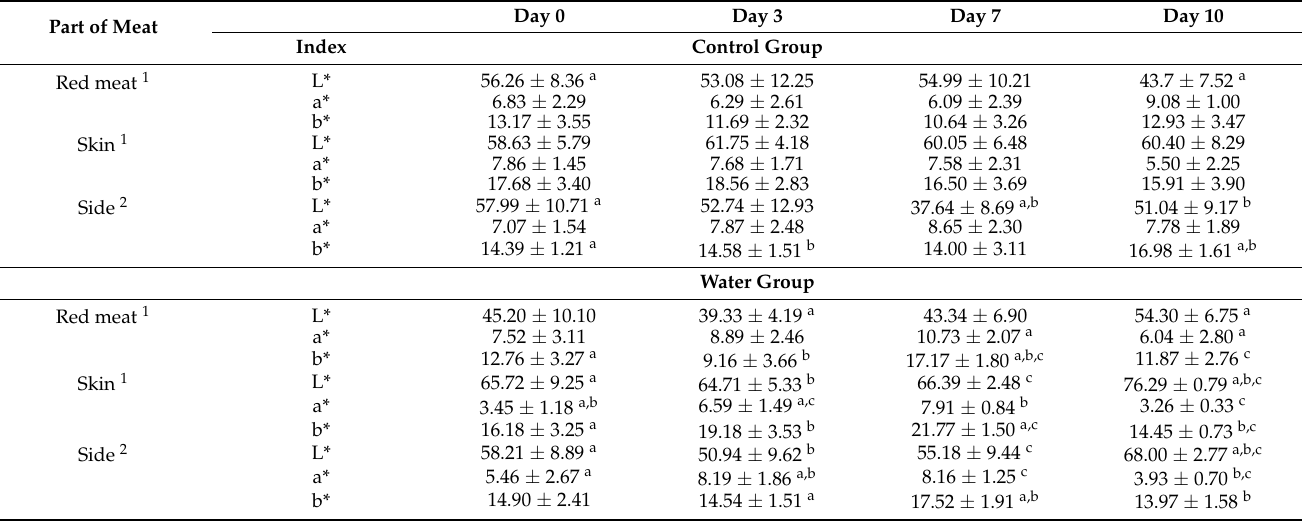
Table 9. Means of color values based on lightness (L*), the red–green index (a*), and the yellow– blue index (b*) on the surface of the pork samples in the control, water immersion, and liquid plasma